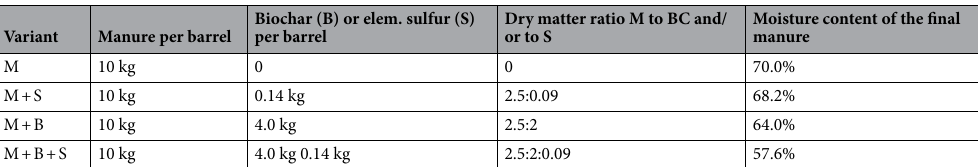
Table 1. Preparation of manure variants—dosage of amendments, moisture content.